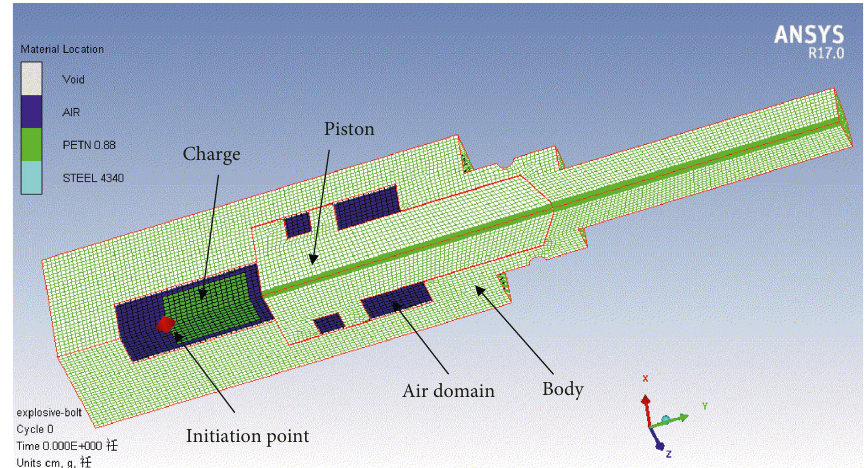
Figure 8: Numerical model of the explosive